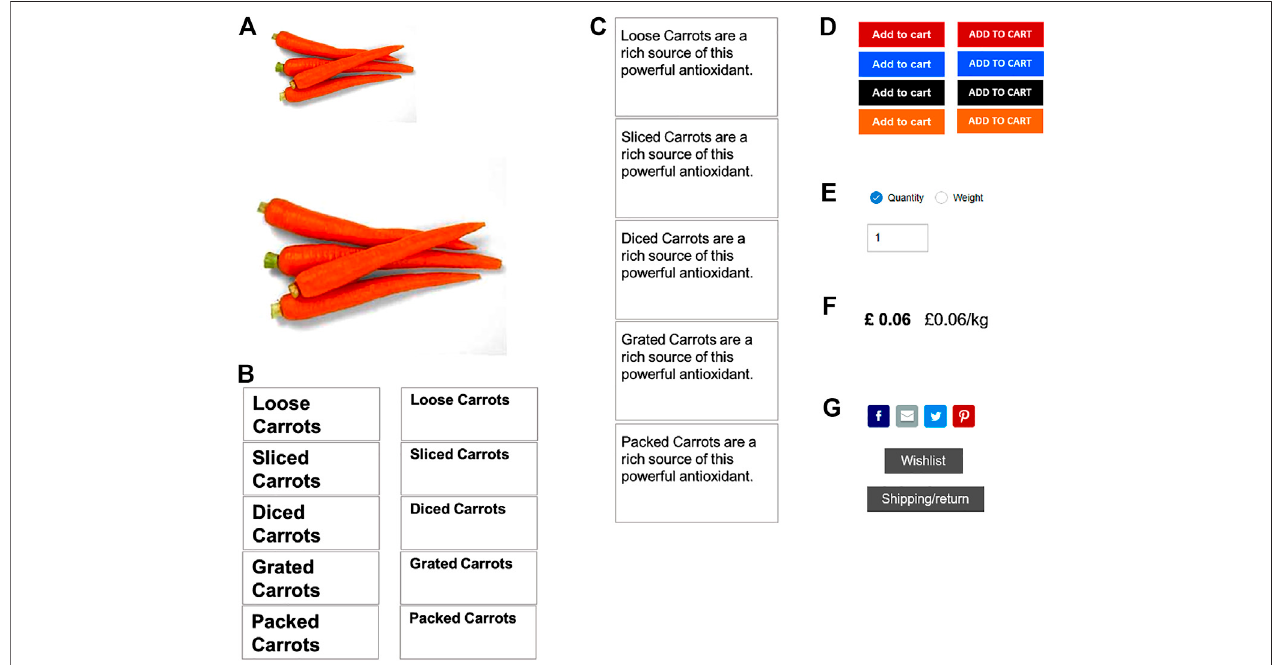
FIGURE3| Roomsettingfortheco-design activity.Participantswereseatedatadeskwiththedesignmaterialslaidoutinfrontofthem. Theresearchersatacross from the participant, and there was a video camera positioned to capture the co-design activities.